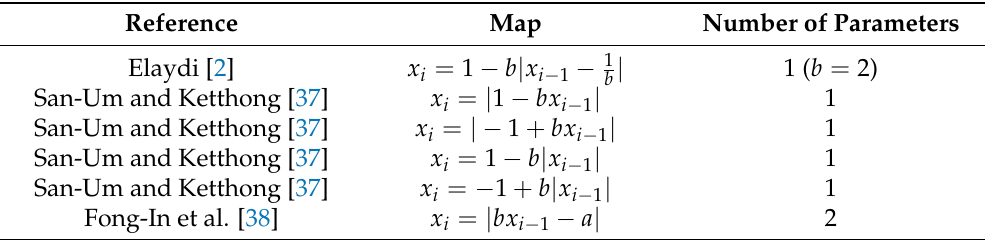
Table 1. Chaotic maps with absolute value